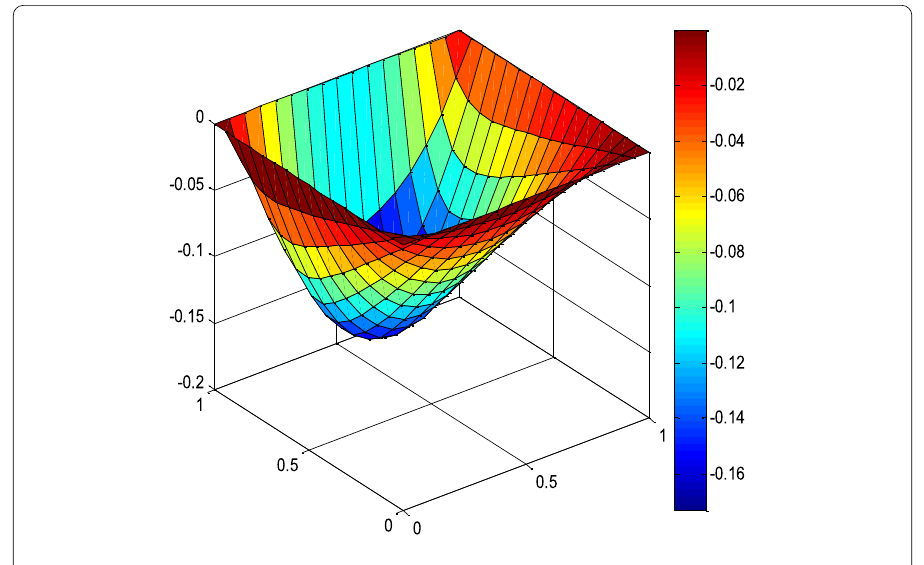
Figure 7 The solution of L1-TFPM of γ = 0.3, hx = hy = 1/16